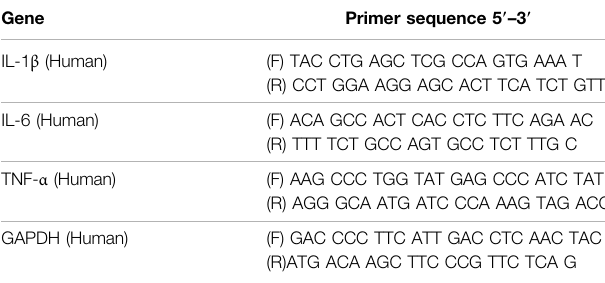
TABLE 1 | Primer sequences used for RT-PCR in this study. Abbreviations: IL-1 β , interleukin-1 β ; IL-6, interleukin-6; TNF- α , tumor necrosis factor- α ; GAPDH, glyceraldehyde 3-phosphate